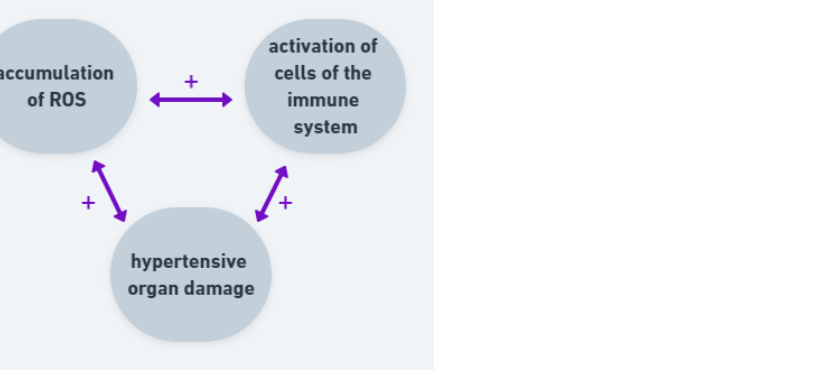
Figure 4. Correlation and positive feedback between ROS, immune cells and hypertensive organ damage. Accumulation of ROS leads to activation of cells of the immune system and both factors lead to hypertensive organ damage. The organ damage intensifies ROS production and activates immune system.